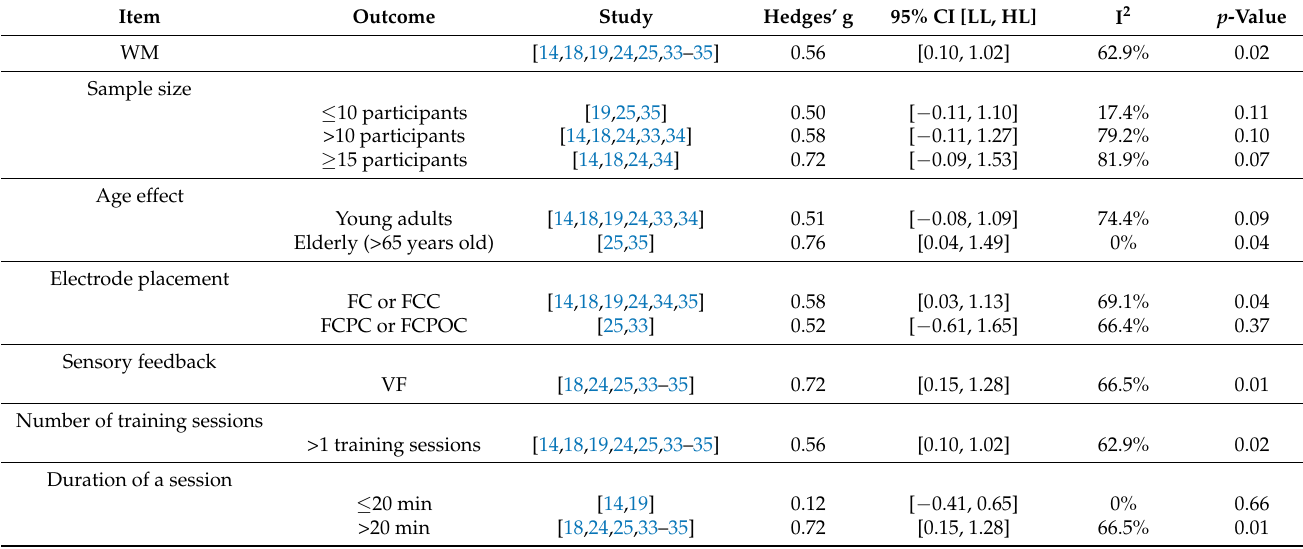
Table 3. Summary of various outcome measures in the included WM